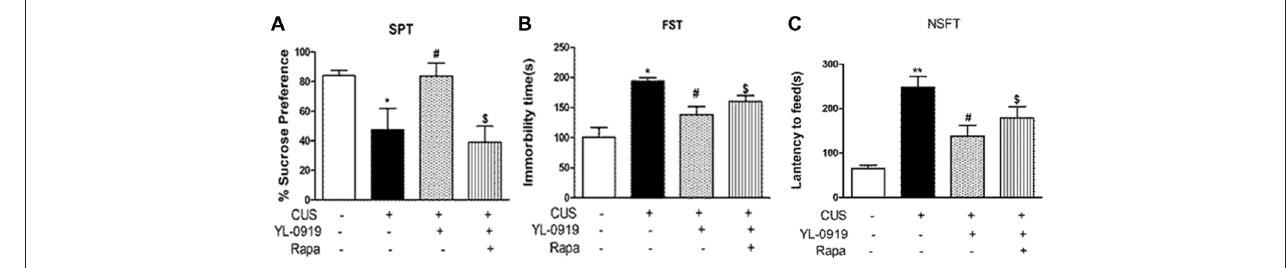
FIGURE 3 | Effects of rapamycin (0.2 nmol in 2 µ L DMSO, i.c.v.) on behavioral tests assessing depressive-like behavior in rats exposed to CUS. YL-0919 (2.5 mg/kg, i.g.) or saline were administered i.g. 1 h after rapamycin treatment. (A) Effects of rapamycin on the SPT score of CUS-exposed rats after 3 days treatment with YL-0919. (B) Effects of rapamycin on the FST score of CUS-induced rats after treatment with YL-0919 for 5 days. (C) Rapamycin (Rapa) effects on the novelty-Suppressed Feeding Test (NSFT) in rats exposed to CUS after 10 days treatment with YL-0919. All behavioral tests were completed 1 h after drug administration. n = 8; ∗ ,# P < 0.05, ∗∗ P < 0.01; ∗ ,# compared to vehicle and YL0919, respectively; $ P < 0.05, compared to Rapa; two-way ANOVAs followed Tukey’s post hoc test.